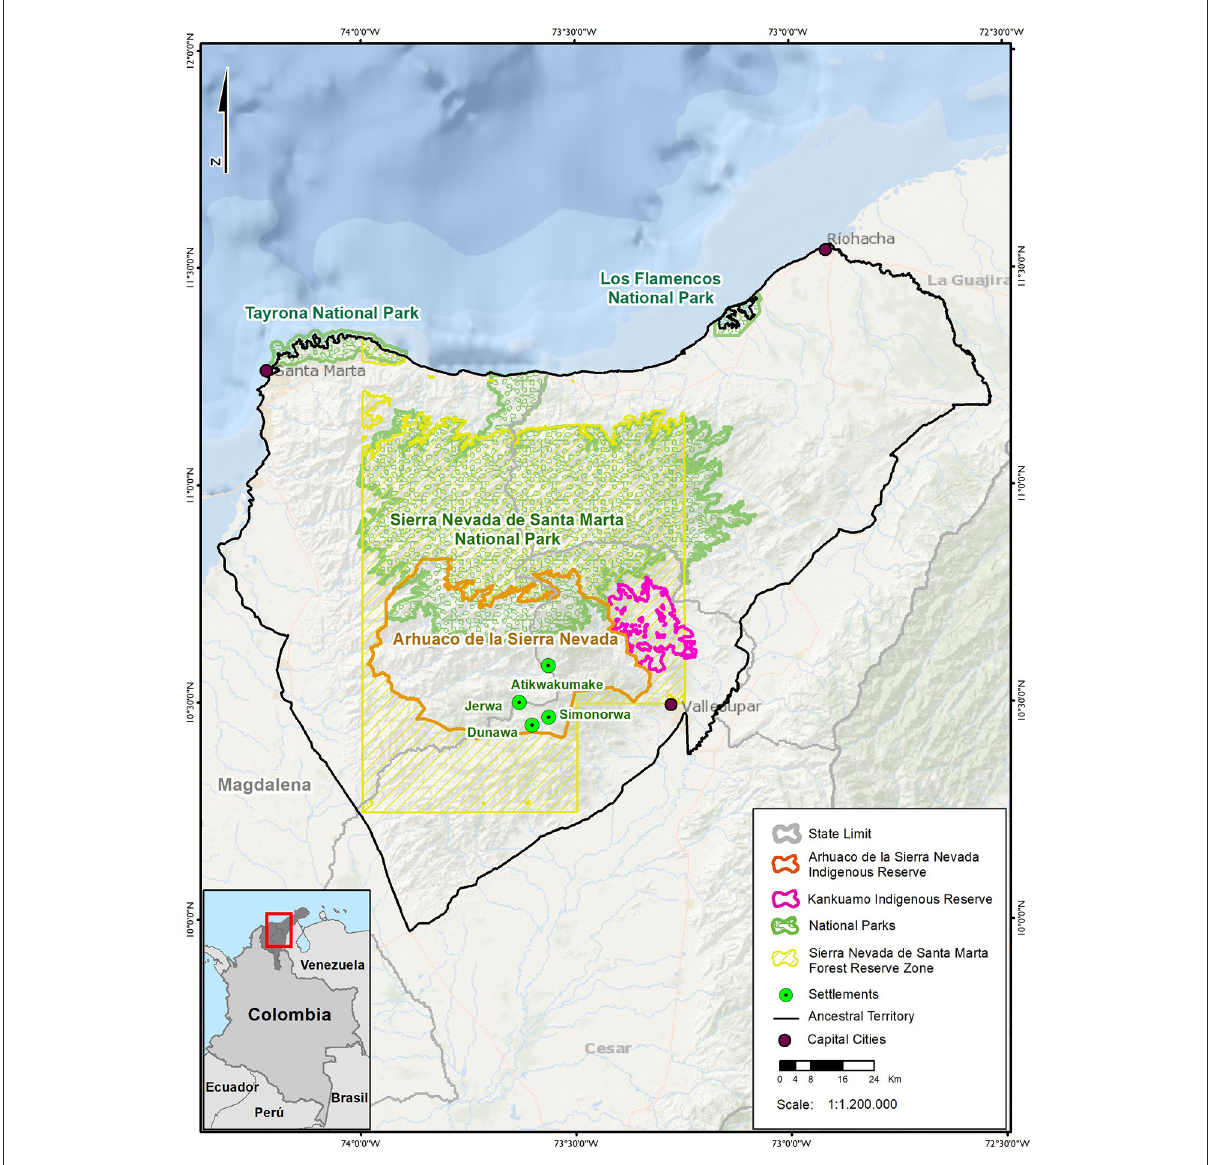
FIGURE2 Study area. It shows the four Arhuaco settlements, the indigenous reserves, and protected areas.